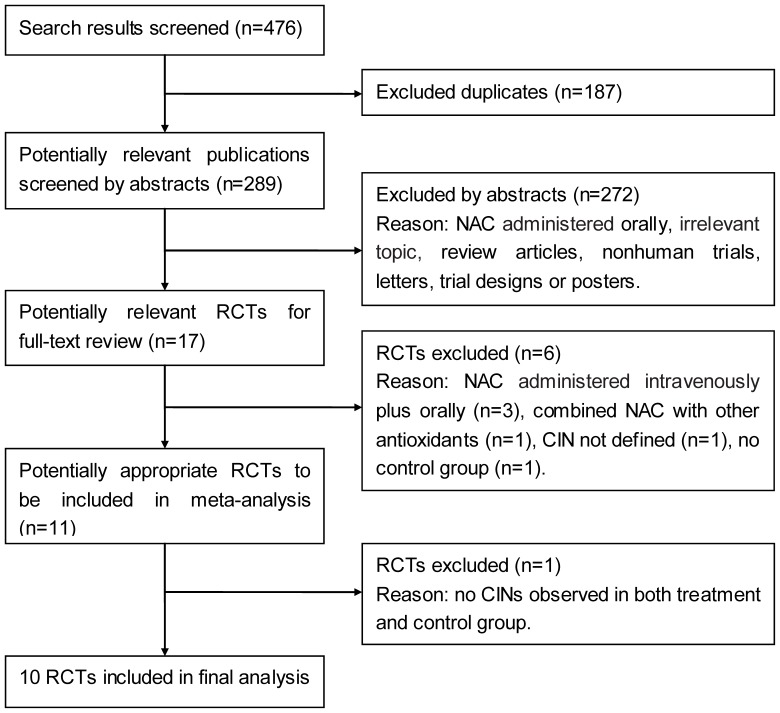
Flow diagram of selection process.Abbreviations: RCT = randomized controlled trial.